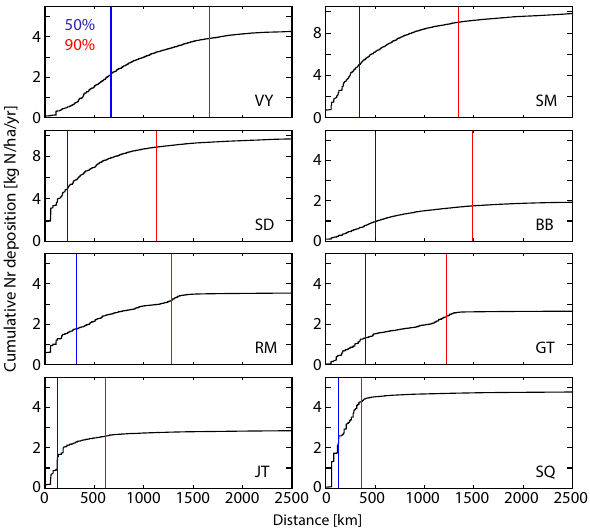
Figure 6. Annual averaged monthly cumulative contribution as a function of distance from the site. Vertical lines are for 50% (blue) and 90% (red) of total Nr deposition. Note the change in scale of the y axis for SM and SD.